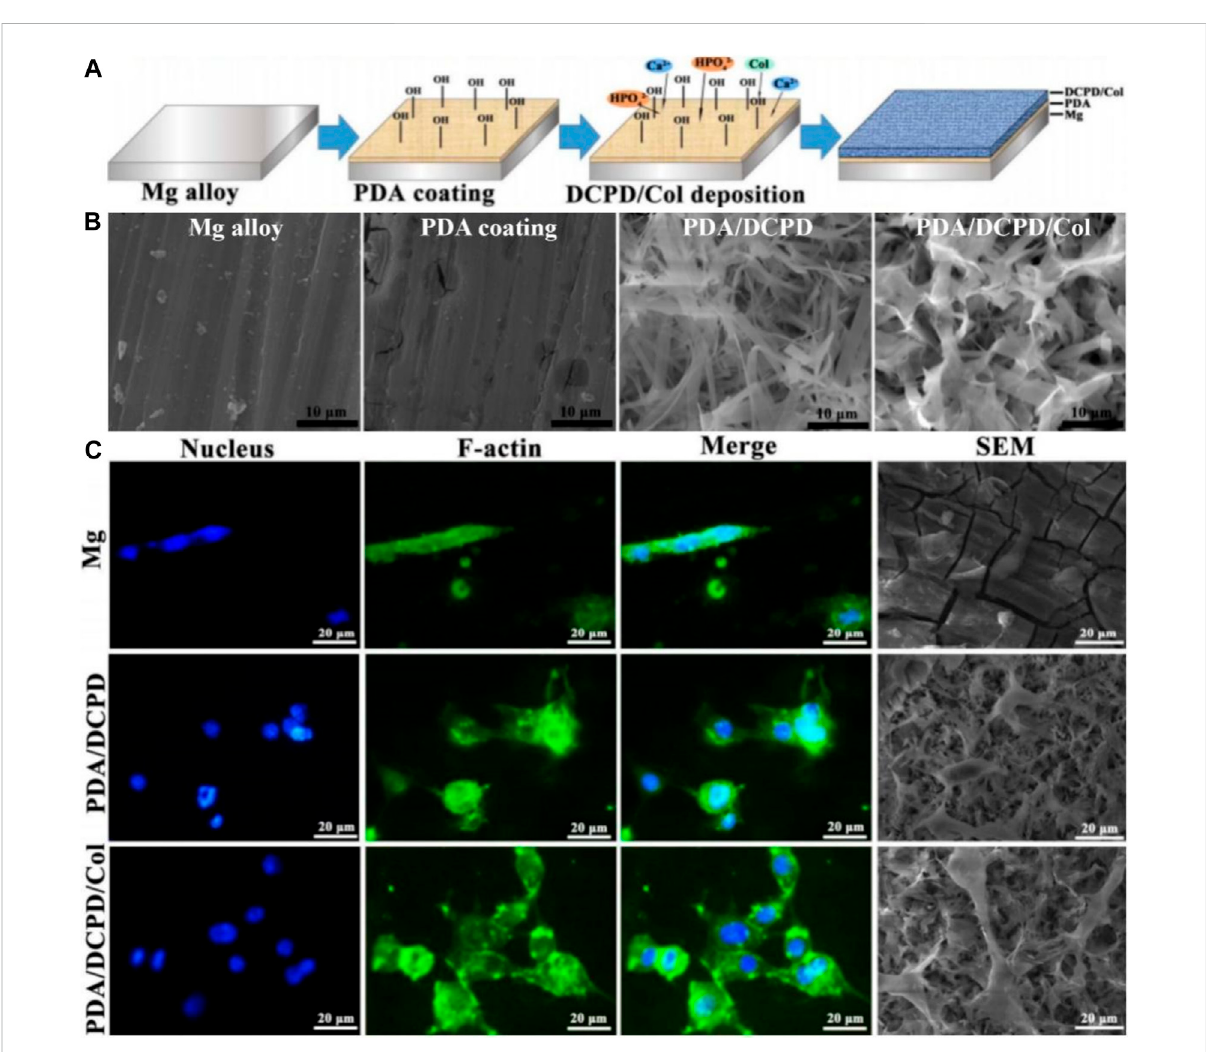
FIGURE 3 Mg alloy coated with polydopamine/dicalcium phosphate dihydrate/collagen composite for orthopedic applications (Guo et al., 2020). (A) The illustration of Mg alloy coated with polydopamine/dicalcium phosphate dihydrate/collagen composite preparation. (B) SEM images of different materials. (C) FluorescenceimagesandSEMimagesofMC3T3-E1cellsondifferentsamplesaftercultured for24 h(Reproducedfromthereferences with